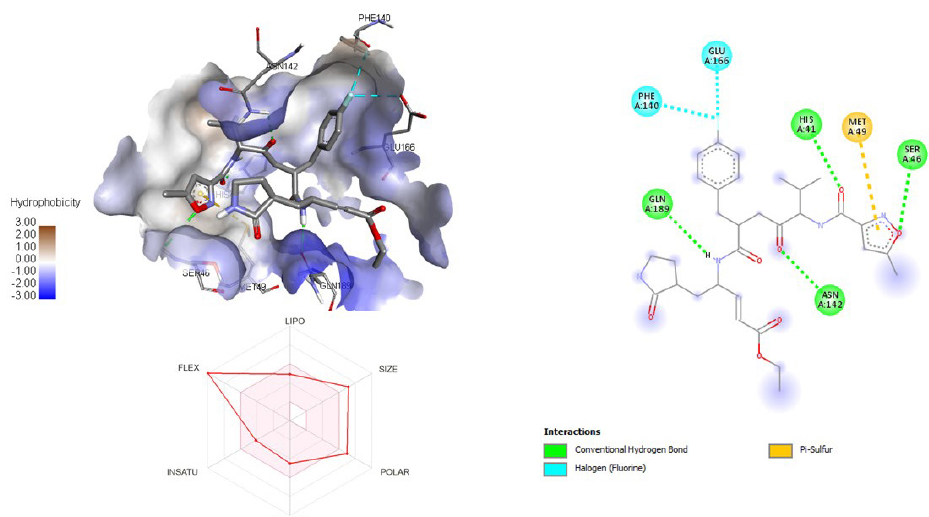
Figure 5. 3D and 2D interaction of ligand rupintrivir with SARS-CoV-2 protein (PDB ID: 7P35) along with in silico absorption, distribution, metabolism, excretion, and toxicity (ADMET) representation